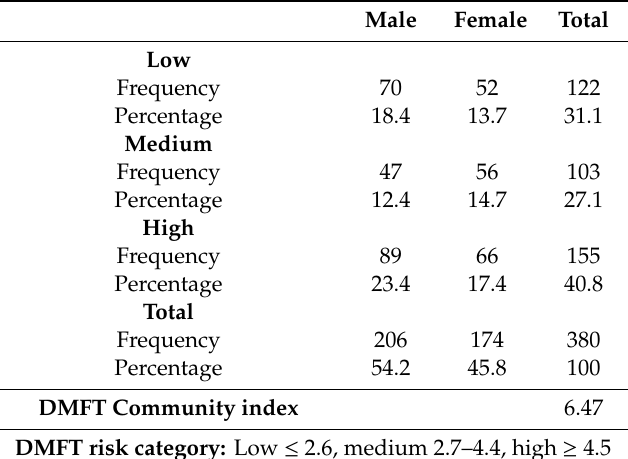
Table 1. DMFT risk levels and